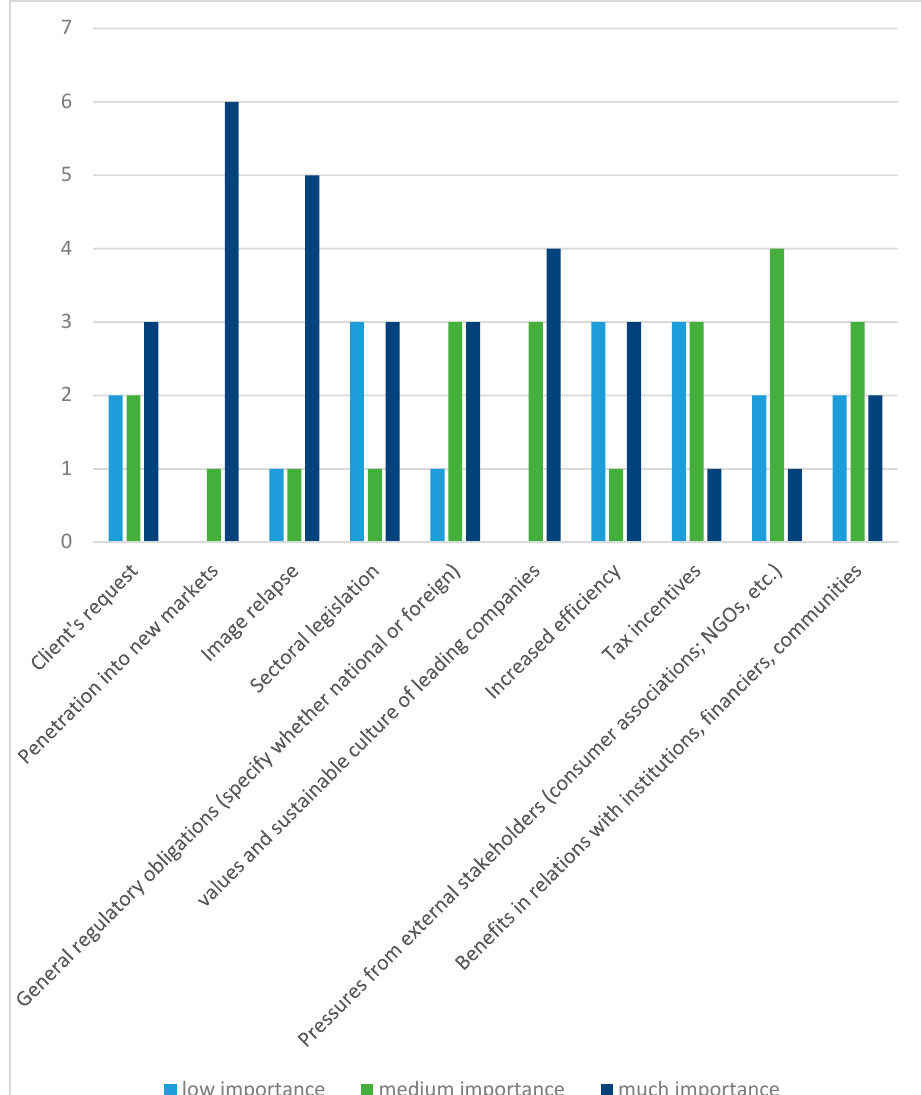
Figure 3. Companies’ reasons to adopt sustainability initiatives/projects.